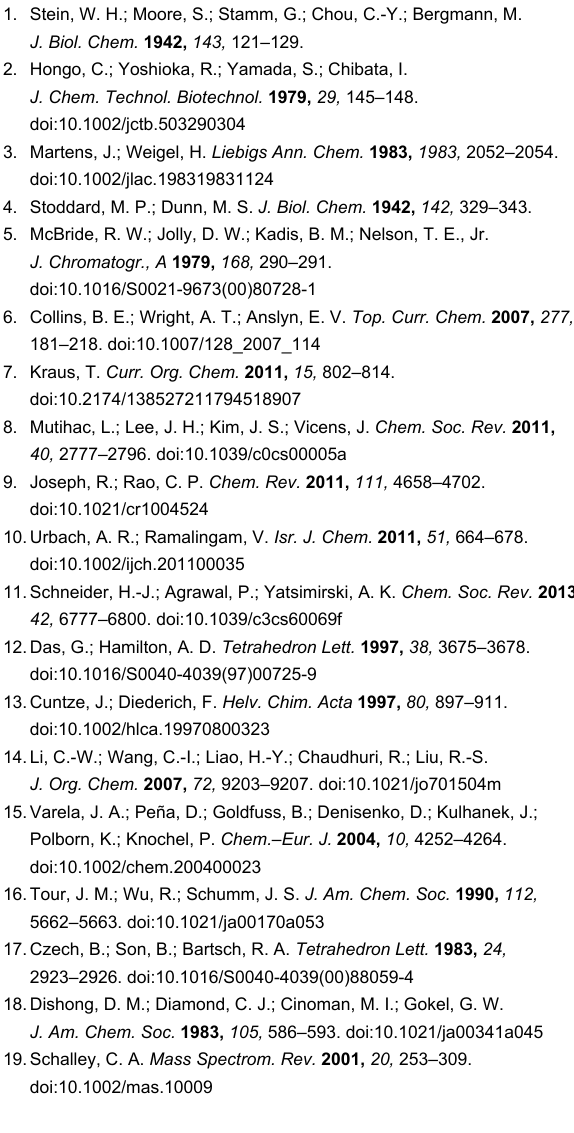
Figure 6: Two different motifs for the binding of substrates to the templates.